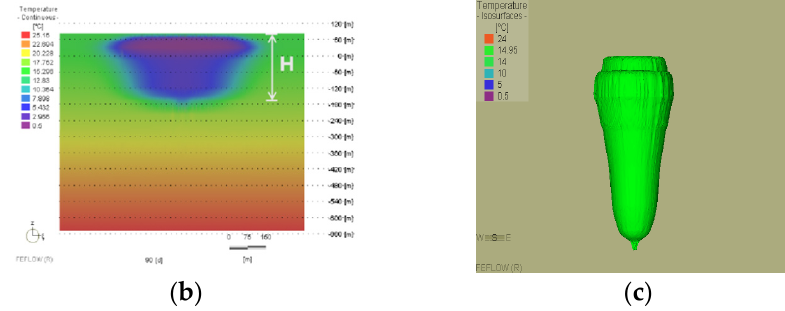
Figure 5. Temperature field thermal transfer map: ( a ) horizontal thermal transport, ( b ) vertical thermal transport, and ( c ) three-dimensional thermal transport.